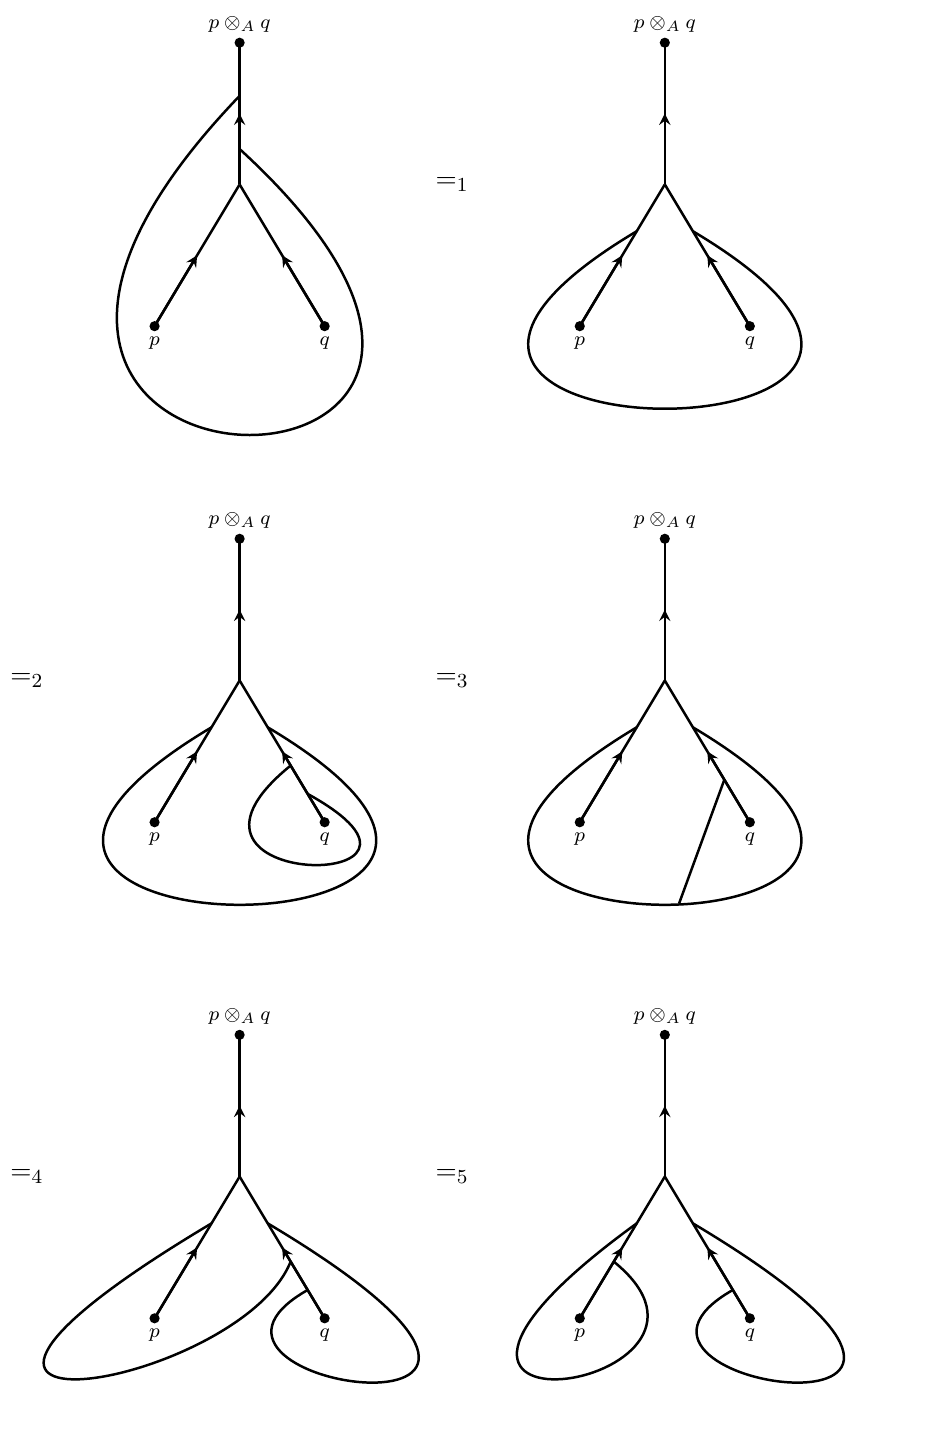
Figure 52 . The new product ~ M and its well-de(cid:12)nedness. For details of the manipulation, see the main